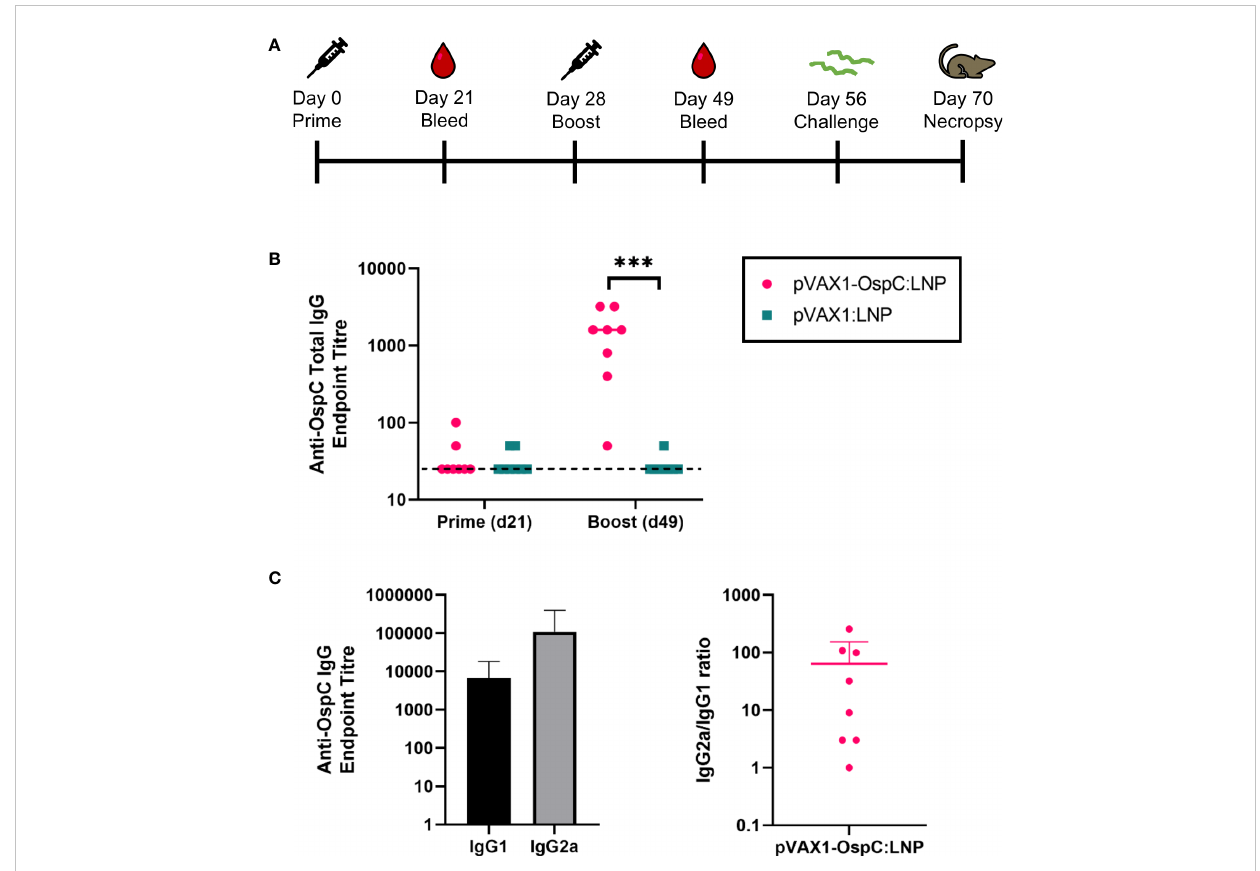
FIGURE 1 pVAX1-OspC:LNP vaccination is immunogenic in mice. (A) Schematic depicting the immunization and challenge schedule in C3H/HeN mice. Mice were bled on day 21 and day 49. Eight mice per group were injected intramuscularly with pVAX1-OspC:LNP or pVax:LNP on day 0 and day 28. Mice were challenged subcutaneously with 1 × 10 5 Borrelia burgdorferi B31 on day 56 and sacri fi ced on day 70 for tissue collection. (B) ELISA determination of OspC-speci fi c IgG antibody titres in serum of mice three weeks after prime (day 21) or boost (day 49) injections. Dashed line indicates the limit of detection. Samples pertaining to data points on the dashed line have antibody titres below the limit of detection. (C) Titres and ratio of IgG2a and IgG1 OspC-speci fi c serum antibodies three weeks after boost immunization (day 49). Error bars represent standard deviation. *** p-value <